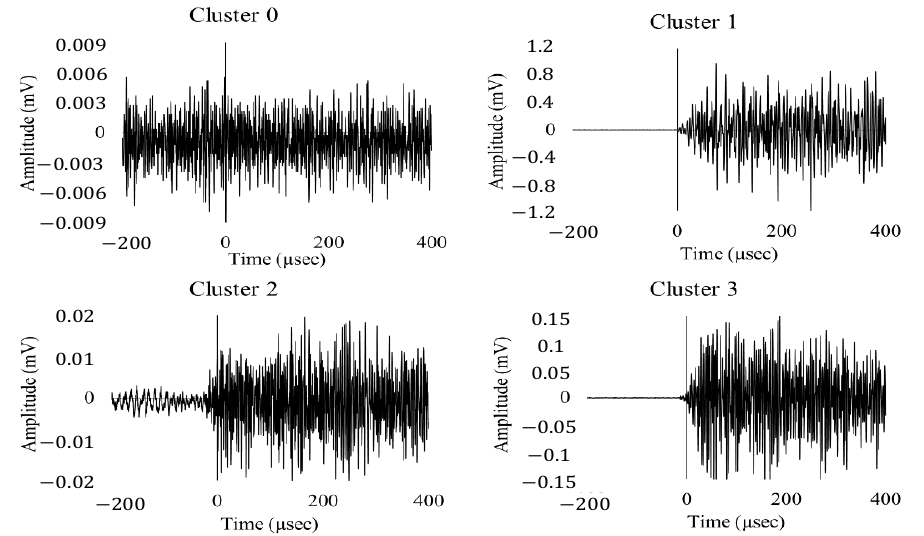
Figure 10. Clustering results for all three experiments; Cluster with respect to principal components (left side image); Cluster with respect to energy and rise time(right side image).